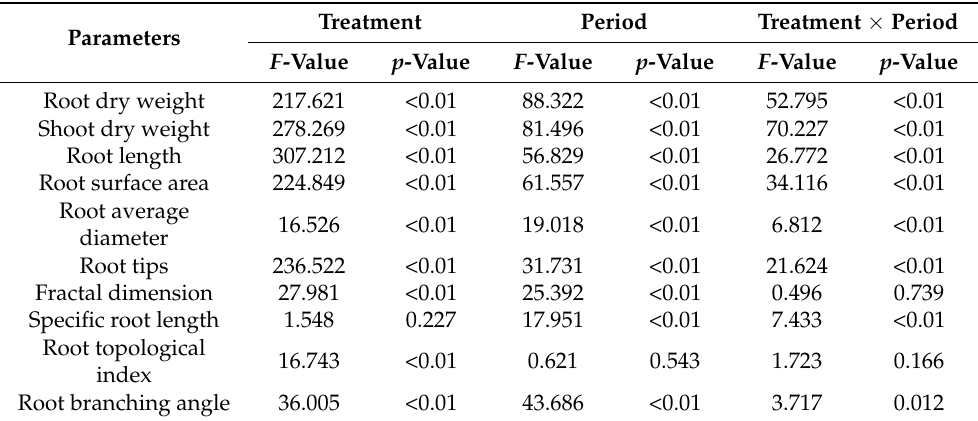
Table 1. Effects of treatments, periods, and their interactions on plant growth and root architecture